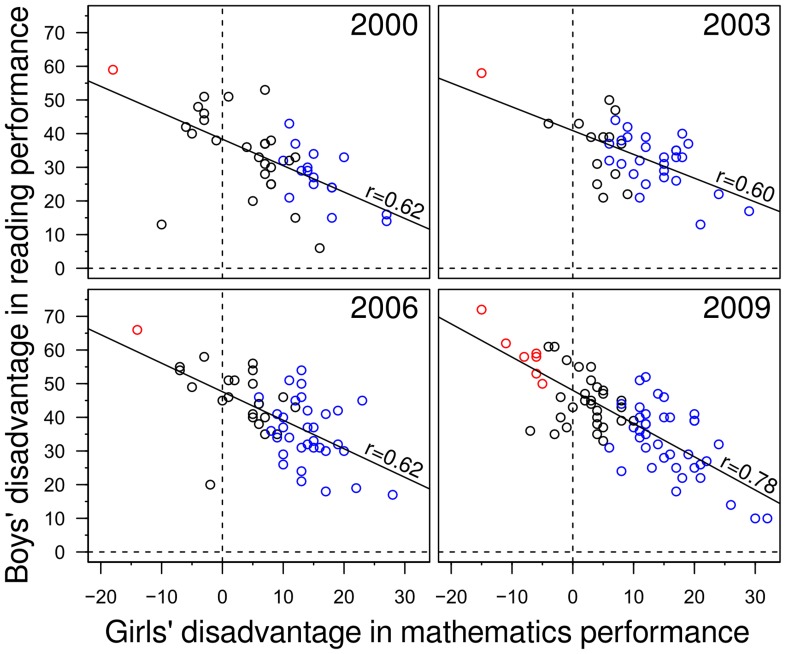
Negative correlation between boys’ disadvantage in reading achievement (y-axis) and girls’ disadvantage in mathematics achievement.Each data point indicates the sex differences of one country. Positive values indicate a larger disadvantage, negative values an advantage. Red points indicate nations in which girls’ mathematics achievement is significantly higher than that of boys; blue points indicate nations in which boys’ mathematics achievement is significantly higher than that of girls; and, black points indicate nations in which there is no statistically significant difference in mathematics achievement. The advantage of girls in reading achievement is statistically significant in all nations, except for 2 in 2000 (Israel, Peru) and one in 2003 (Liechtenstein).